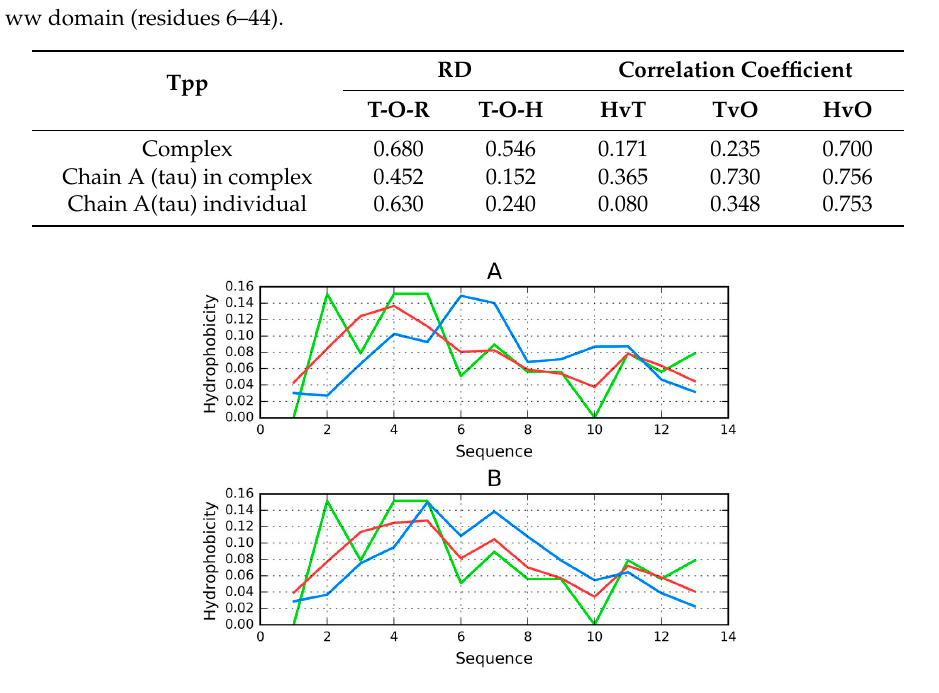
Figure 6. Distribution of hydrophobicity in chain A in the Tpp in complex (T—blue, O—red, H— green): ( A ) when treated as a distinct structural unit; ( B ) when treated as a component of the complex. Good alignment between O, T, and H can be observed in the latter case. alignment between O, T, and H can be observed in the latter